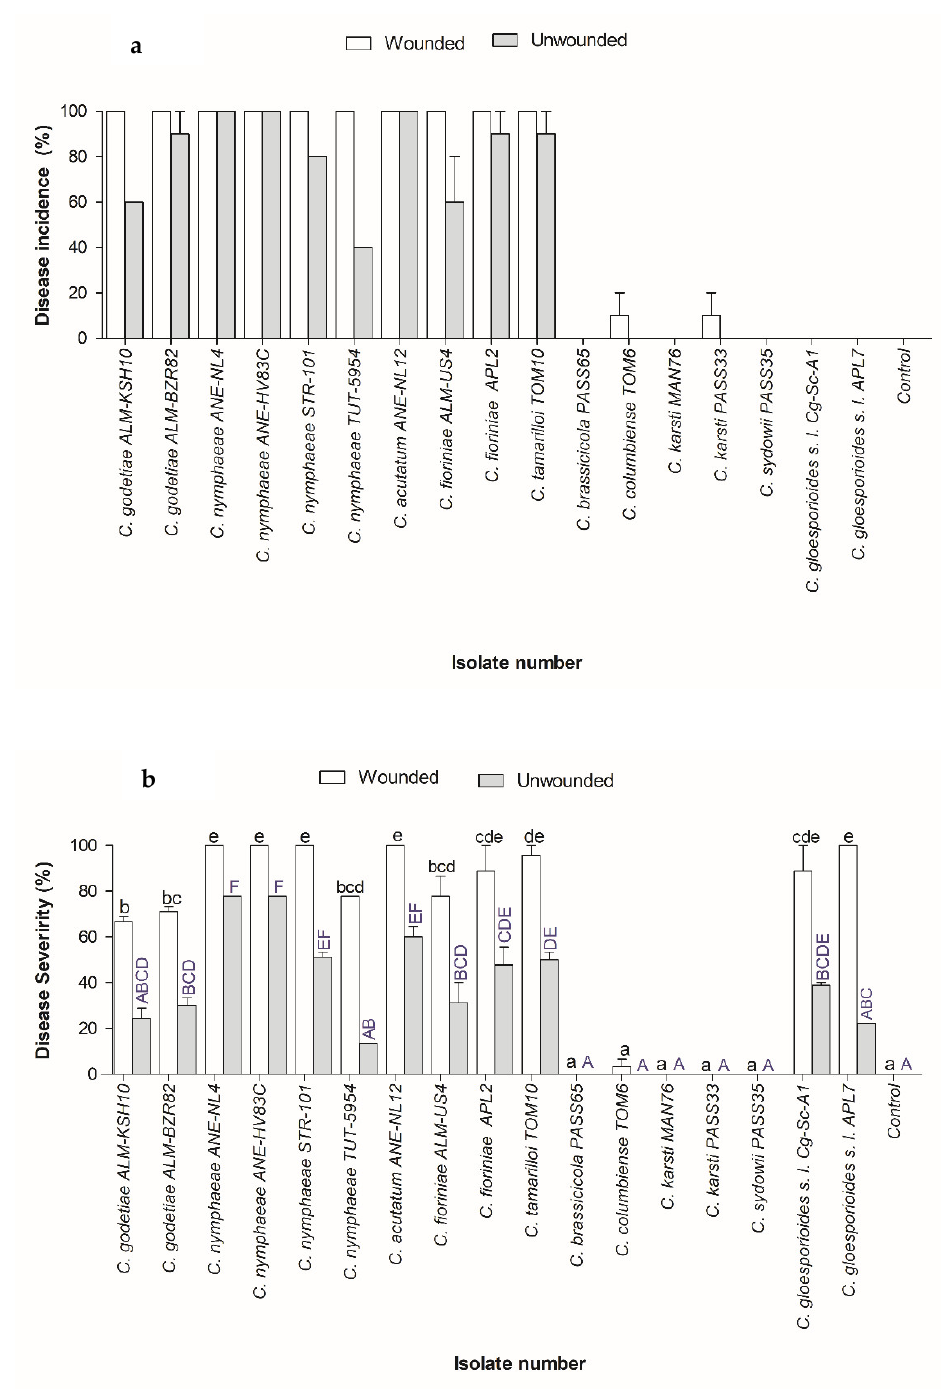
Figure 5. Bar diagram showing the ( a ) percent disease incidence and ( b ) percent disease severity of the representative Colletotrichum isolates used in this study. White bars = wounded fruits; gray bars = unwounded fruits. Data presented are the mean ± standard error. Means with different superscript letters are significant according to Tukey’s post-hoc test (p < 0.05 ).